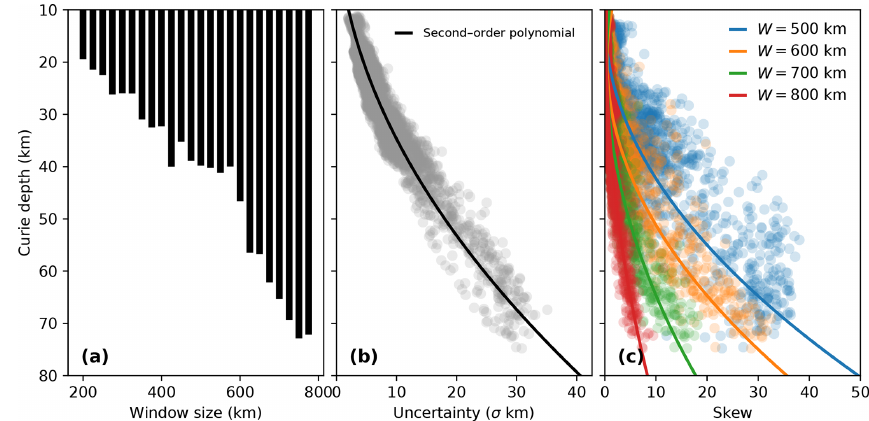
Figure 7. Analysis of Curie depth estimates. (a) The maximum Curie depth that can be resolved for a given window size; (b) the relationship of uncertainty, measured by 1 standard deviation, with respect to Curie depth; (c) the degree of skew exhibited by the posterior probability distribution as a function of Curie depth for different window sizes – skew is defined here as the mean Curie depth less the median.